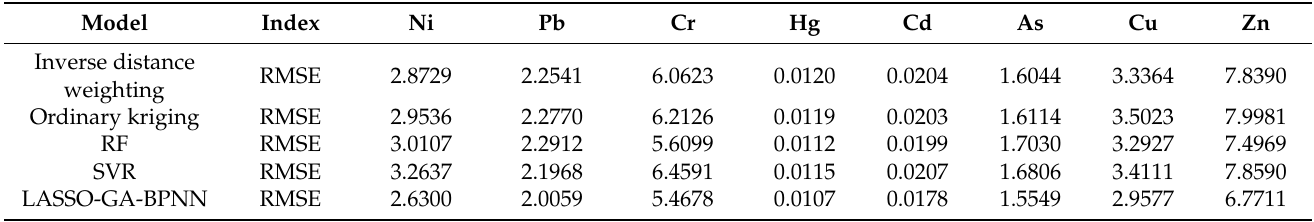
Table 5. The RMSE of the LASSO-GA-BPNN model and spatial interpolation